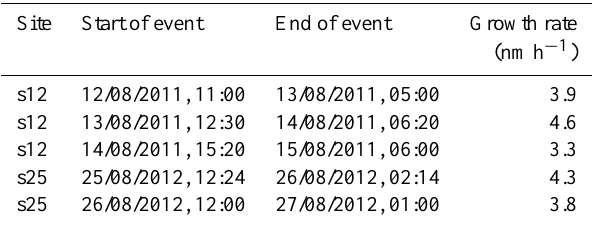
Table 1. Duration of each nucleation event as well as their average growth rates. Growth rates were calculated by a linear fit from 9 to 20nm.